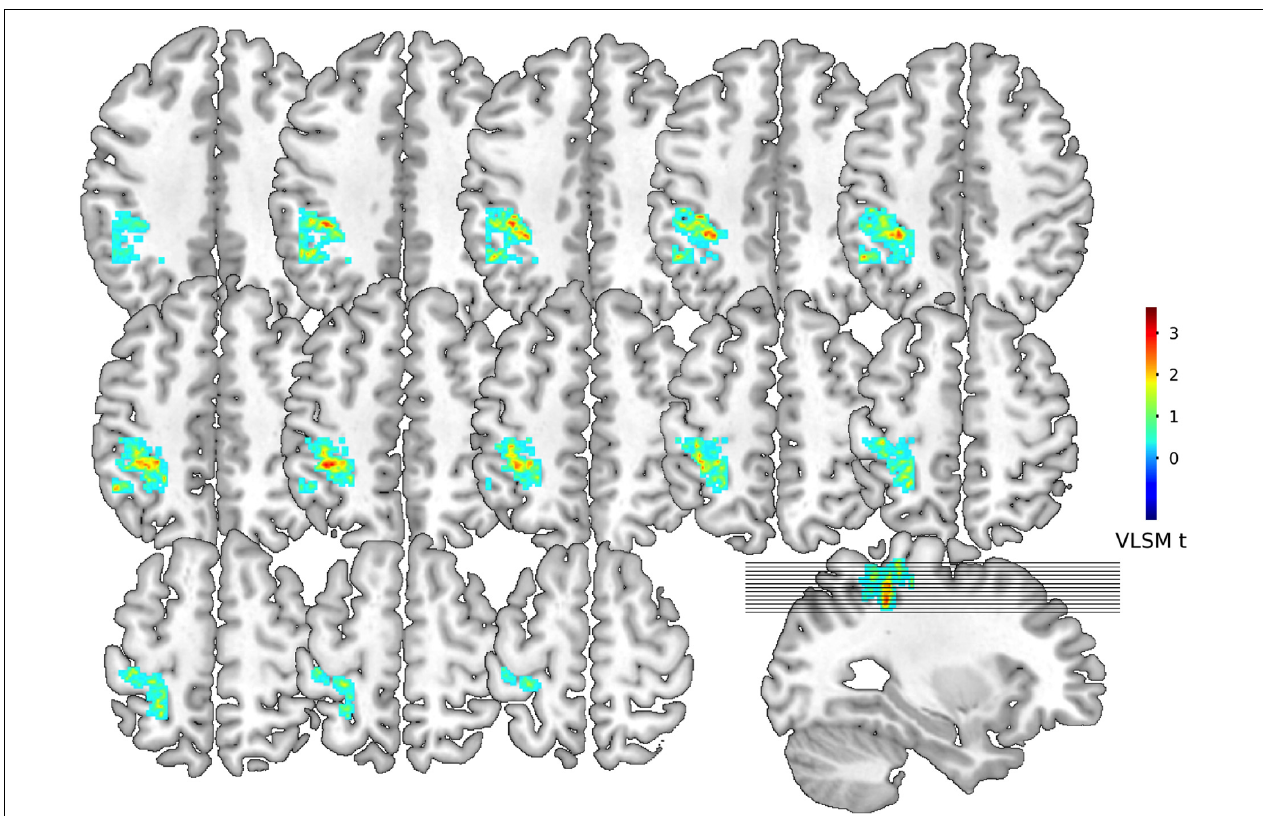
FIGURE 3 | Voxel-based lesion-symptom mapping for dysphagia symptoms. Representative slices from VLSM maps computed for dysphagia symptoms of 275 patients with stroke. These maps are colorized depictions of logistic regression analysis results evaluating patient performance on a voxel-by-voxel basis. The warmer the color is, patients with lesions on the corresponding voxel hold higher chance to develop dysphagia. Age, gender, NIH stroke scale, TOAST classification and progressive stroke effects have been